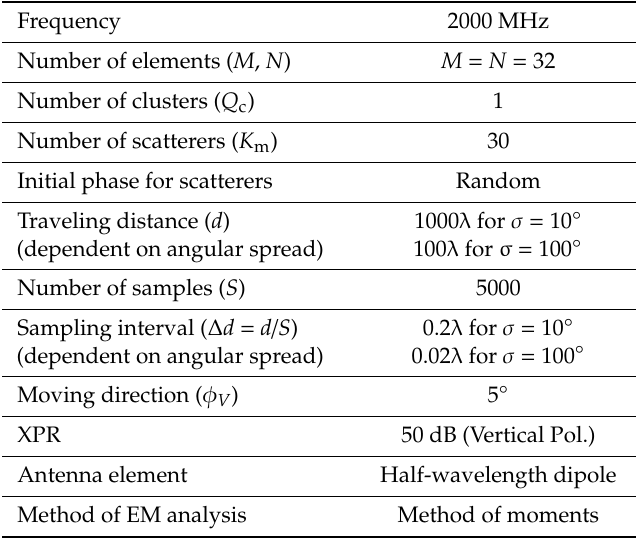
Table 2. Analytical conditions.